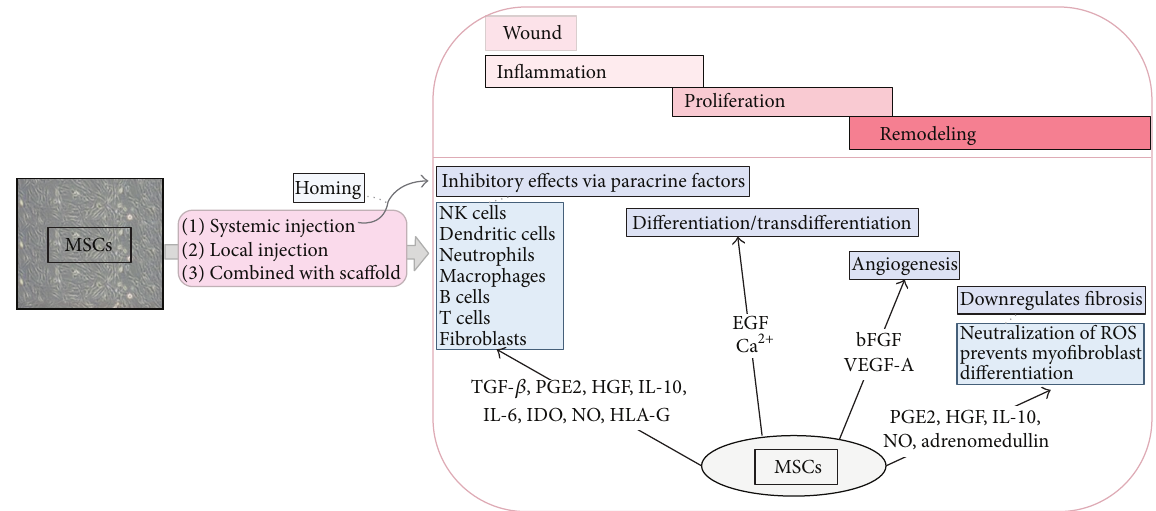
Figure 1: A summary of the immunomodulatory effects of MSCs that downregulate excessive scarring. MSCs are able to home the wound, where the stages of wound healing (inflammation, proliferation, and remodeling) are in progress. MSCs have been found to attenuate the activity of inflammatory cells, differentiate or transdifferentiate into epidermal cell lineages, escalate angiogenesis, and decrease